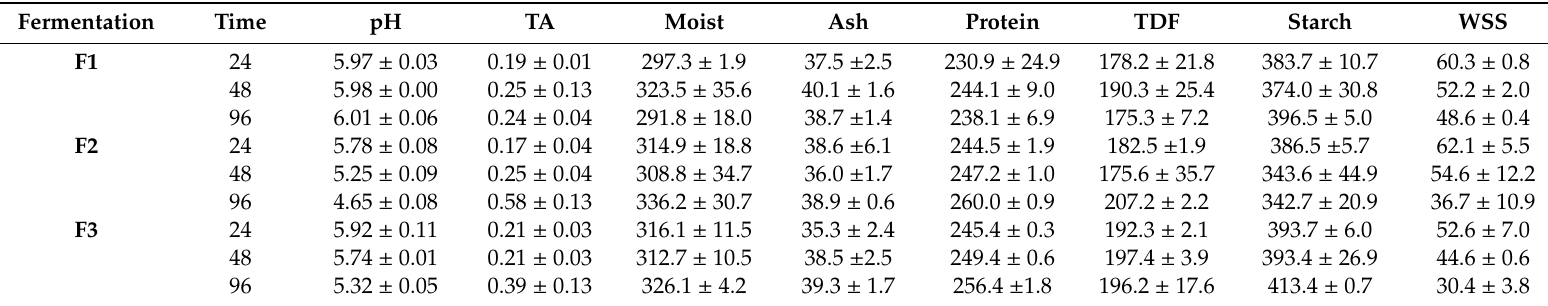
Table 3. Evolution of pH, chemical composition (g · kg − 1 DM) and nutritional characteristics of cowpea beans-flour not inoculated (F1, control), subjected to controlled fermentation with a single culture of Lactobacillus plantarum (F2) or inoculated with a consortium of L. plantarum , Oenococcus oeni, Saccharomyces cerevisiae and Acetobacter aceti (F3) along di ff erent times of fermentation (24, 48, 96 h). All experiments presented as mean values and respective standard deviation ( n = 18). Time